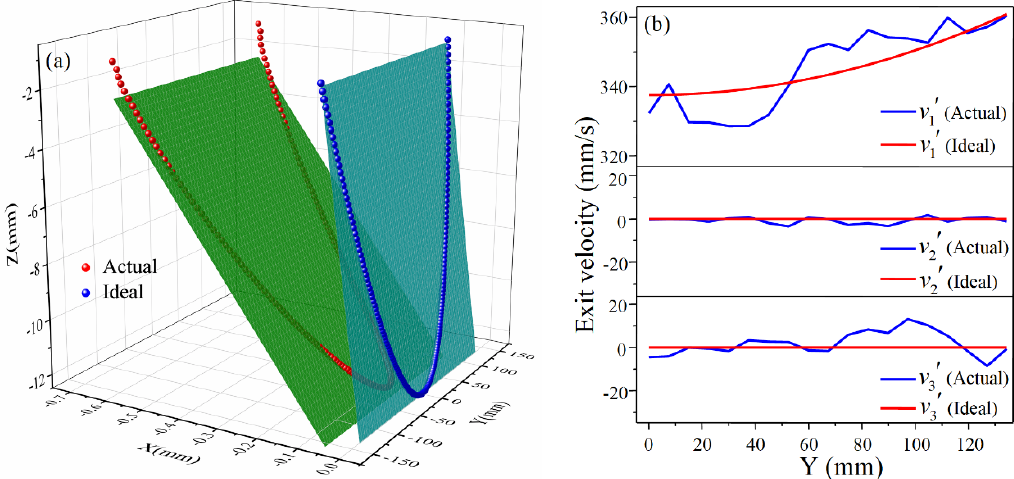
Figure 9. Node distribution of exit cross-section centerline and exit velocity for negative Gaussian curvature surface: ( a ) Node distribution; ( b ) Exit velocity in three directions.